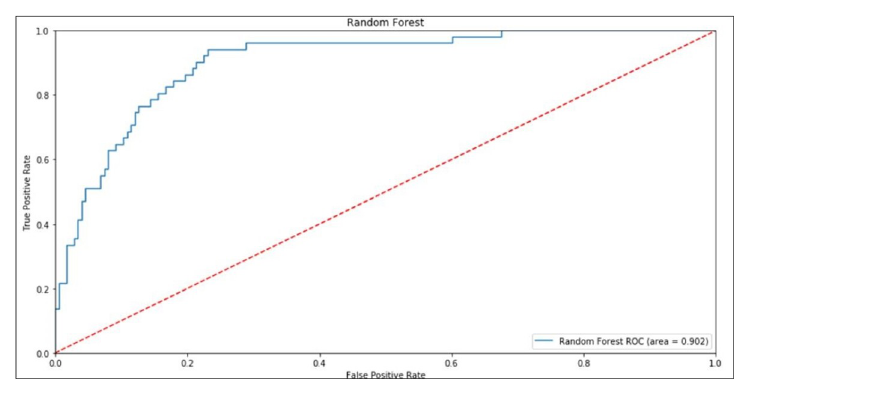
Fig 5. ROC AUC curve of the RF algorithm.